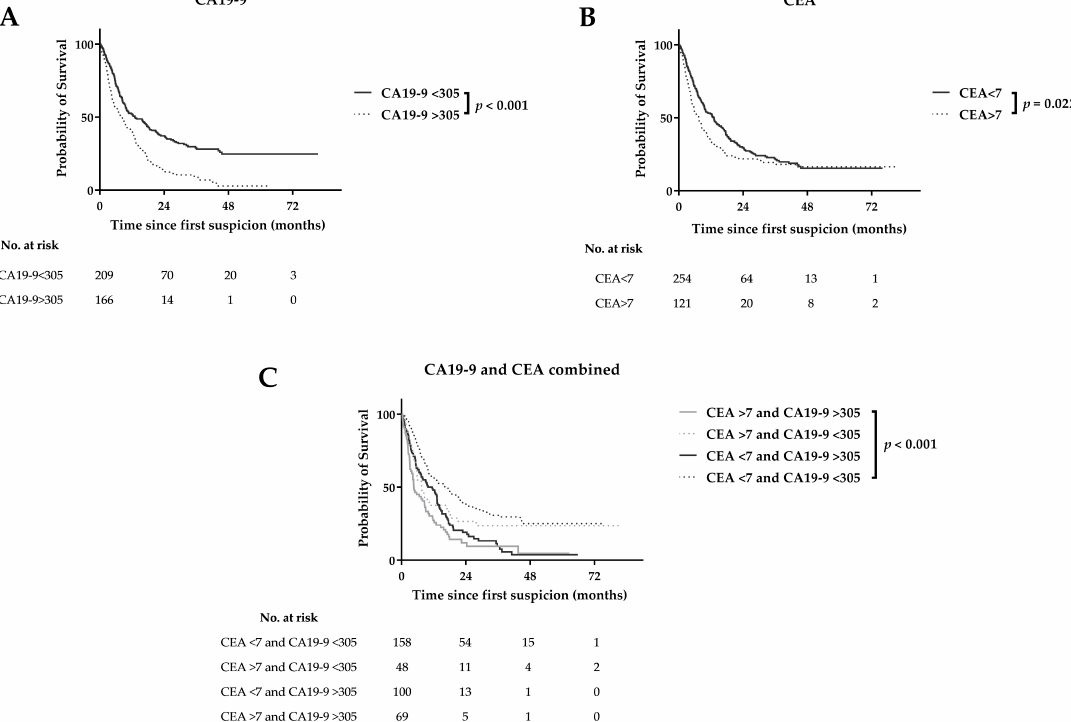
OS (HR: 2.59 (1.52–4.42)). As univariate analysis showed similar OS for pre- and